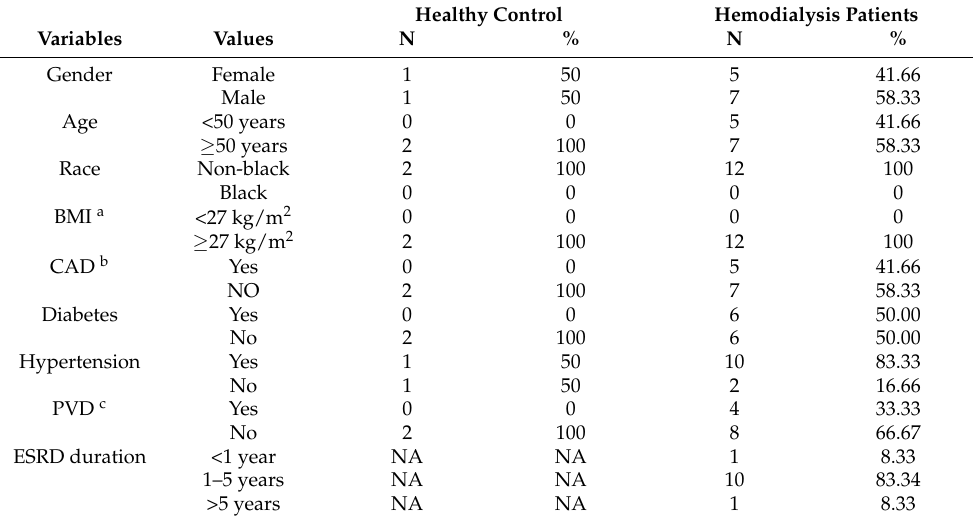
Table 1. Characteristics of the population included in the clinical